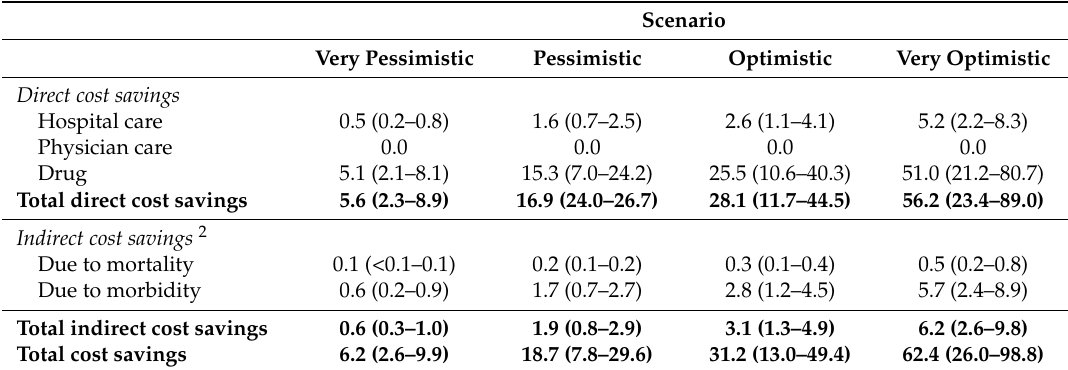
Table 5. Potential annual savings in healthcare and related costs of type 2 diabetes among Canadian adults from low glycemic and/or high fiber diets that include pulses (Can$ million) 1 .